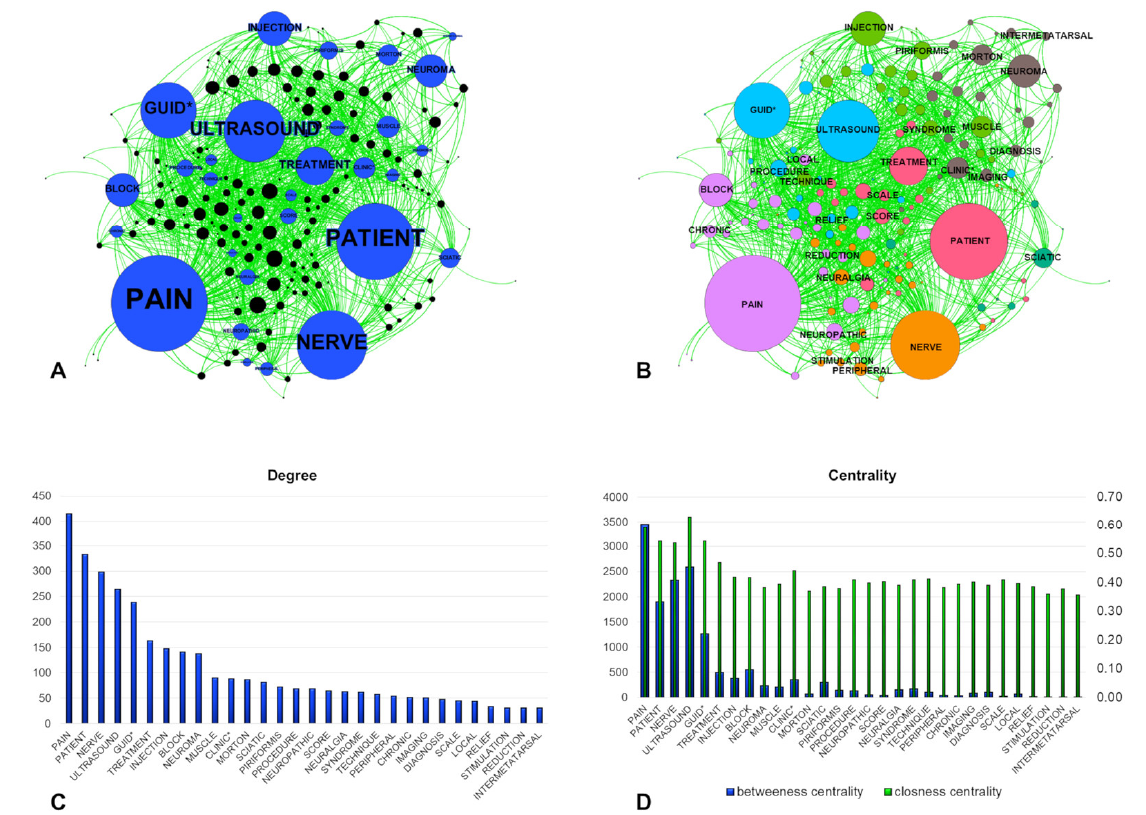
Figure 5. Results of the LENGTH approach. ( A ) The graph on the left represents the connections among words (blue) and papers (black), where the dimensions indicate the degrees. ( B ) The graph on the right considers the modularity classes indicated by different colors. The two bar charts show the degree ( C ) and the centrality values ( D ) of the words. The asterisk indicates the portion following the word root.